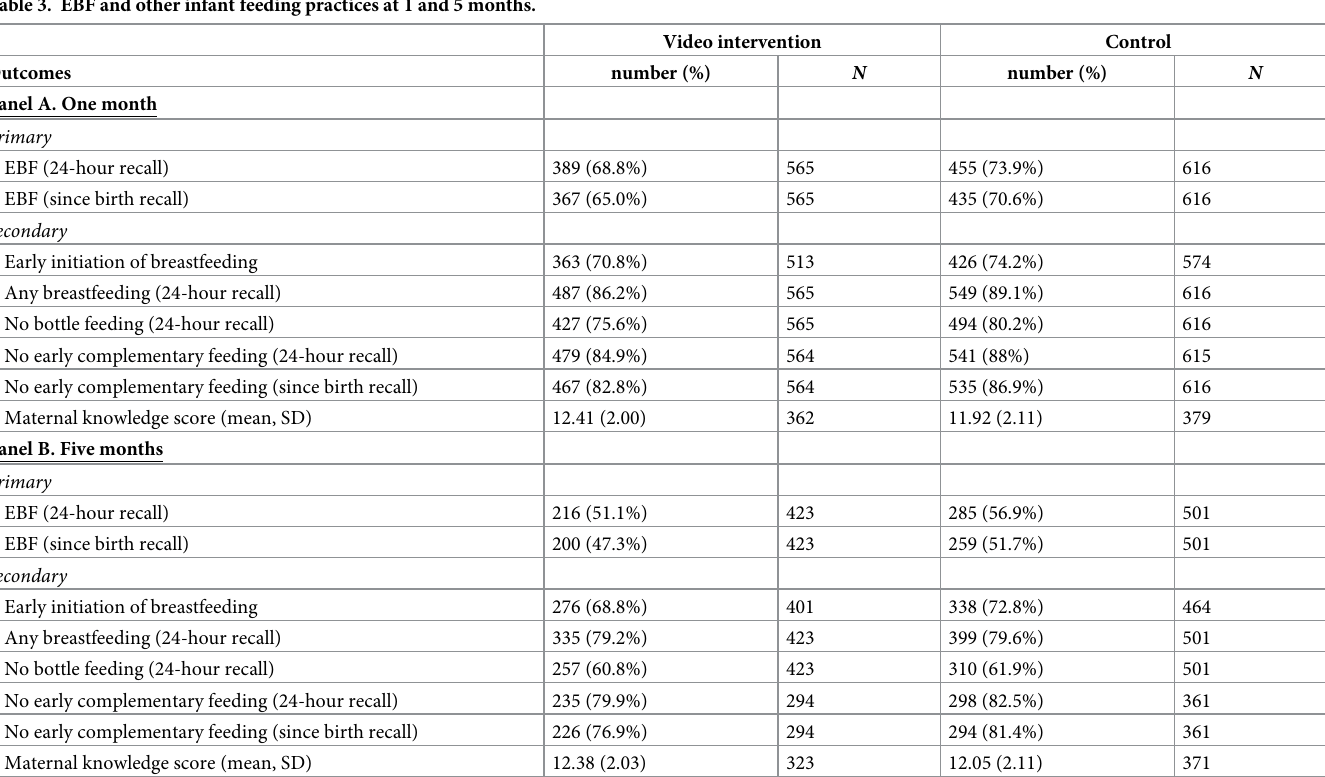
Table 3. EBF and other infant feeding practices at 1 and 5